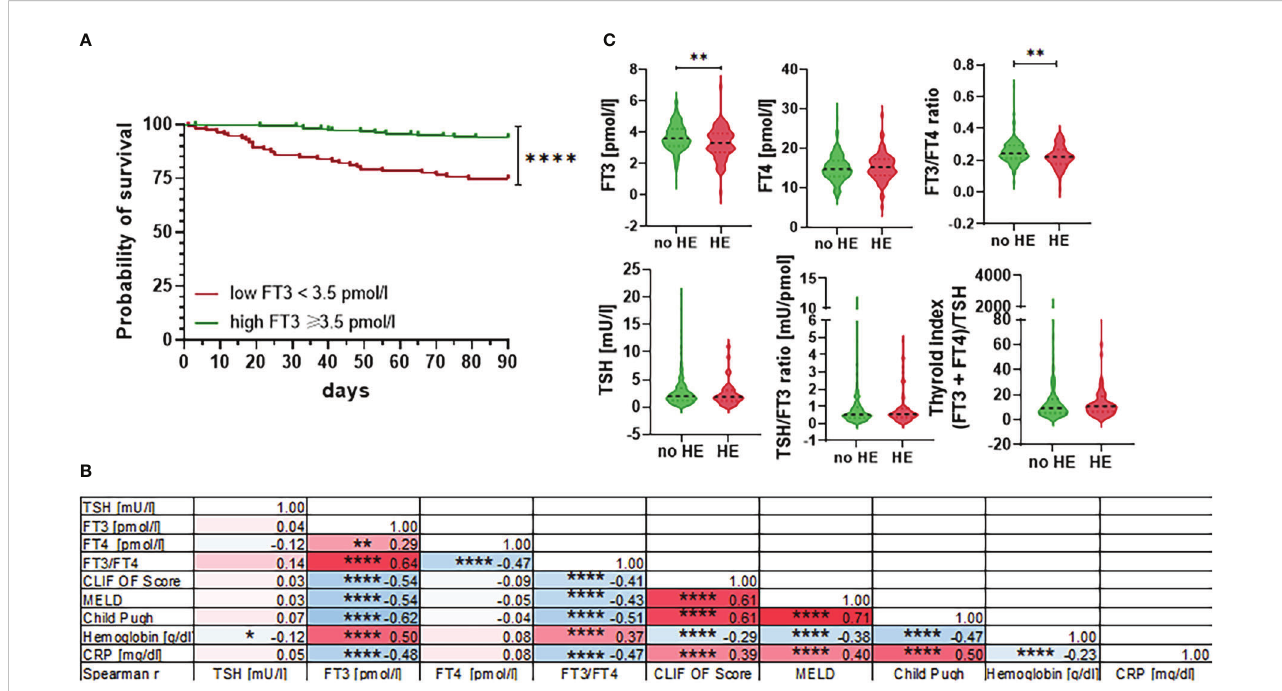
FIGURE 3 Association between thyroid hormones and 90-day mortality, clinical scores and hepatic encephalopathy. (A) Probability of 90-day survival in patients with FT3 concentrations <3.5 pmol/L versus ≥ 3.5 pmol/L. Log-rank test P<0.0001. (B) Correlation matrix of selected thyroid hormone values, clinical scores and laboratory values of patients showing spearman r values and levels of signi fi cance. CRP, C-reactive protein; CLIF OF, CLIF organ failure score; FT3, free triiodothyronine; FT4, free tetraiodothyronine; MELD, Model for End-Stage Liver Disease; TSH, thyroid-stimulating hormone. *P ≤ 0.05, **P ≤ 0.01, ***P ≤ 0.001, ****P ≤ 0.0001. (C) Violin blots of thyroid hormone concentrations are shown for patients with or without hepatic encephalopathy (HE). Graphs show value distribution with median (black dashed line) ± quartiles (colored dashed lines). One-way ANOVA or Kruskal-Wallis test were used as appropriate after Normality Test. *P ≤ 0.05, **P ≤ 0.01, ***P ≤ 0.001, ****P ≤